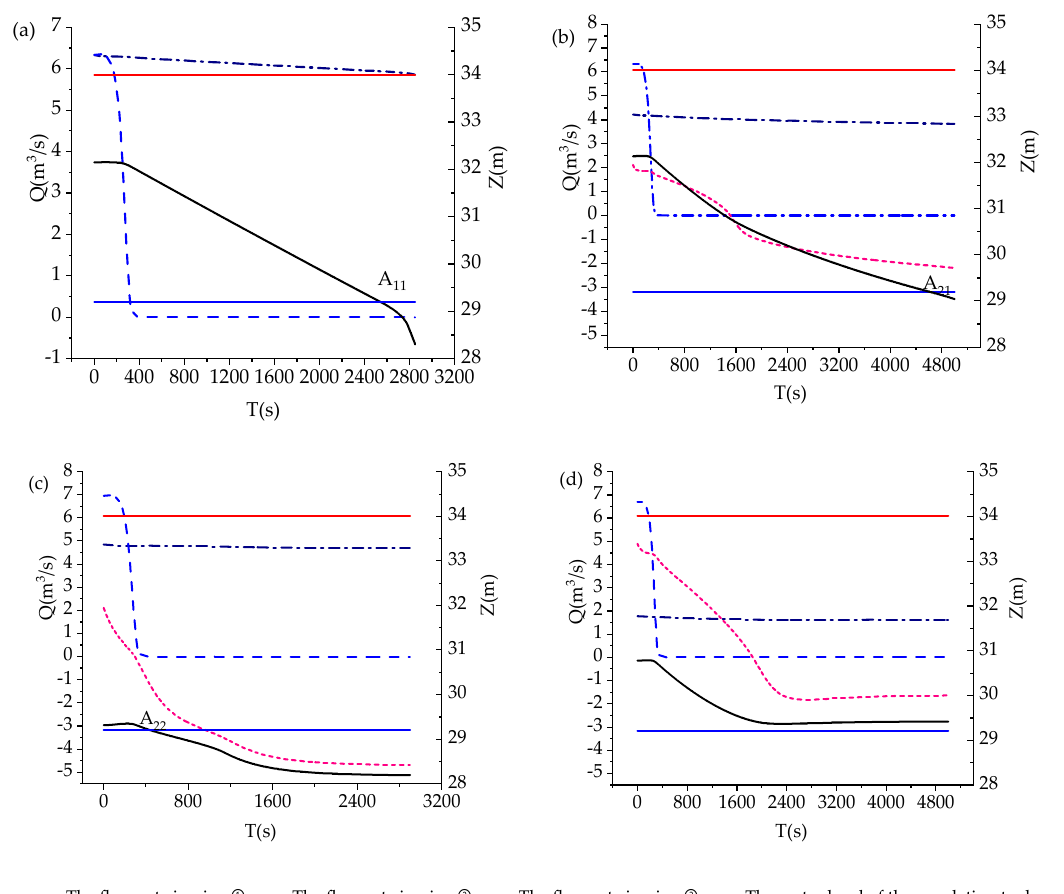
Figure 5. ( a – d ) Transient processes of scheme OS1-C1, OS2-C1, OS2-C2, OS3-C1 under condition D1.